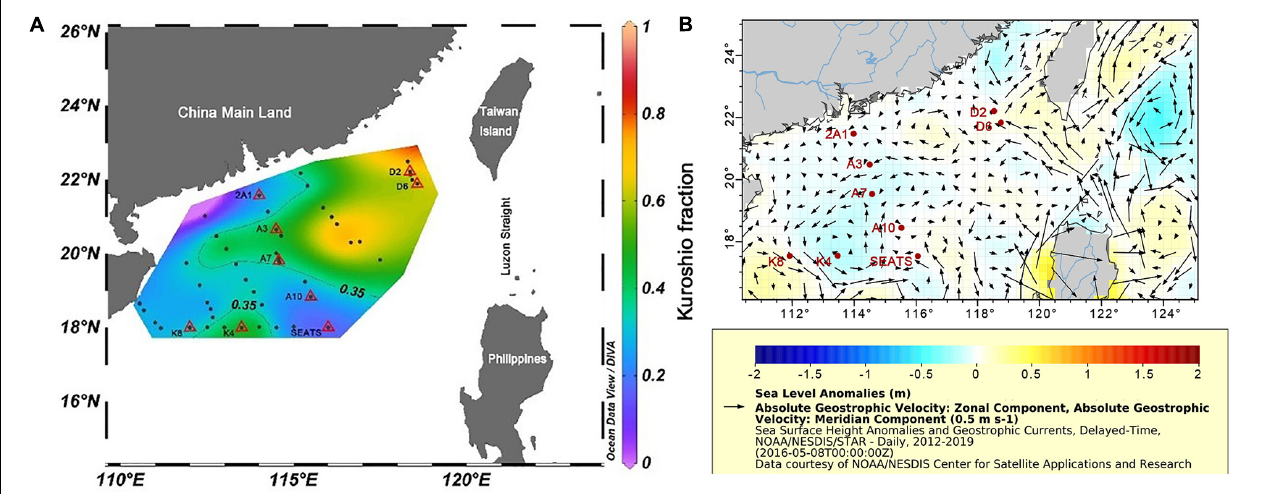
FIGURE 1 | The spatial distribution of (A) averaged Kuroshio fraction for upper 100 m (1 m resolution) at our HTS sampling sites (triangles) in the NSCS during the summer cruise conducted in 2016 and (B) geostrophic currents and sea level anomalies in a week before the cruise. The P4 station was the end-member used in our study for the Kuroshio water. The thin line stands for the isopleth of R K (KI index) of 0.35. The color bar indicates the value R kave − 100 (from 0 to 1).